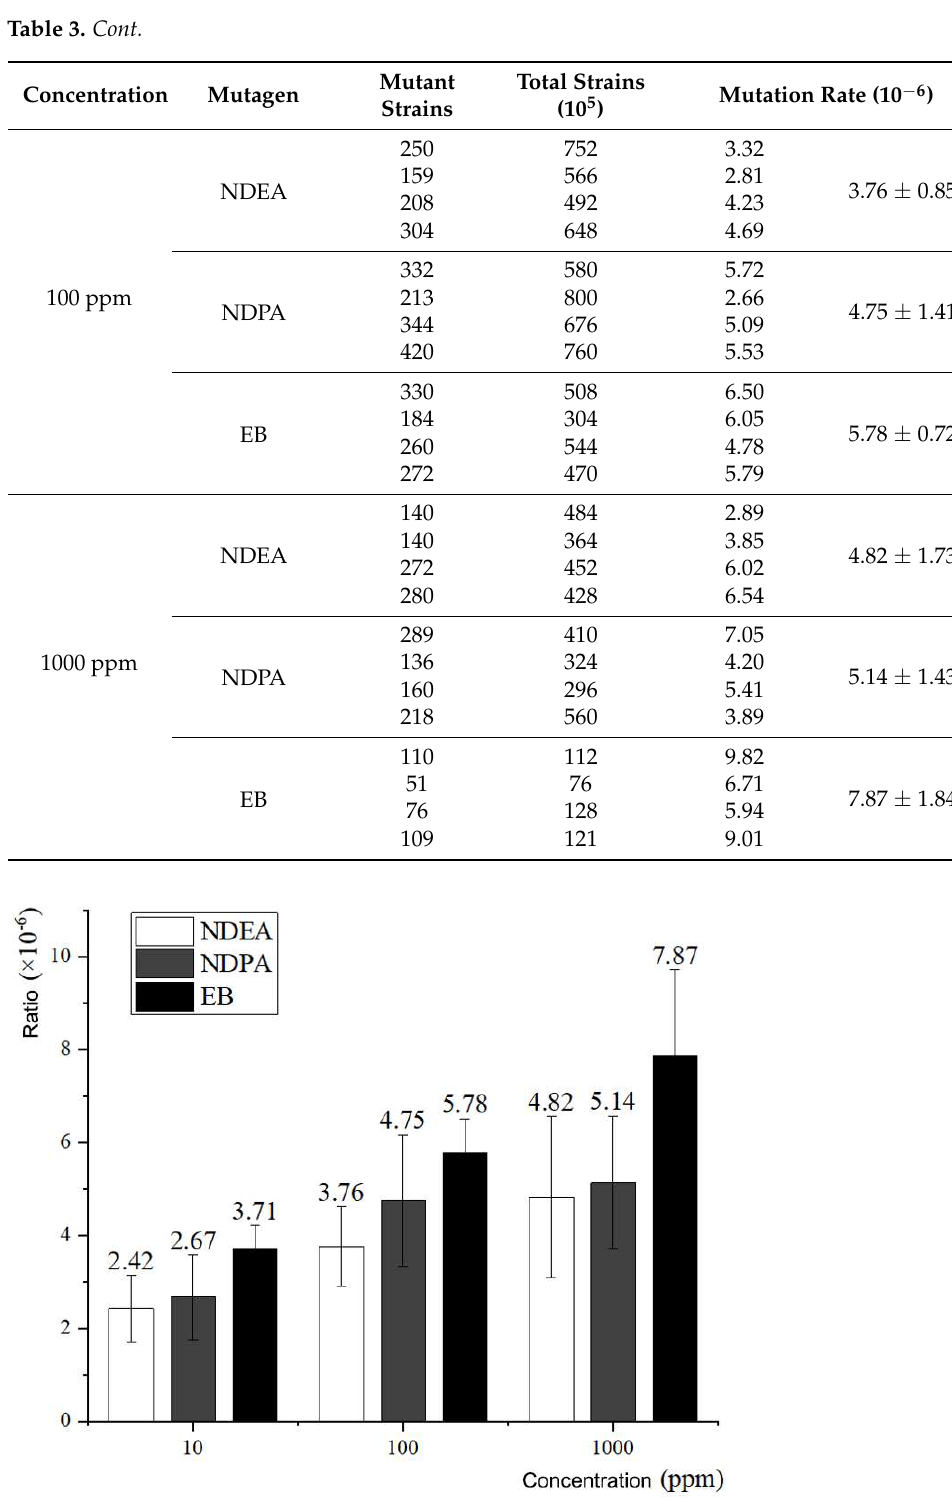
Table 4. Spontaneous mutation rate of rpsL in PCR. Total Strains (10 6 )